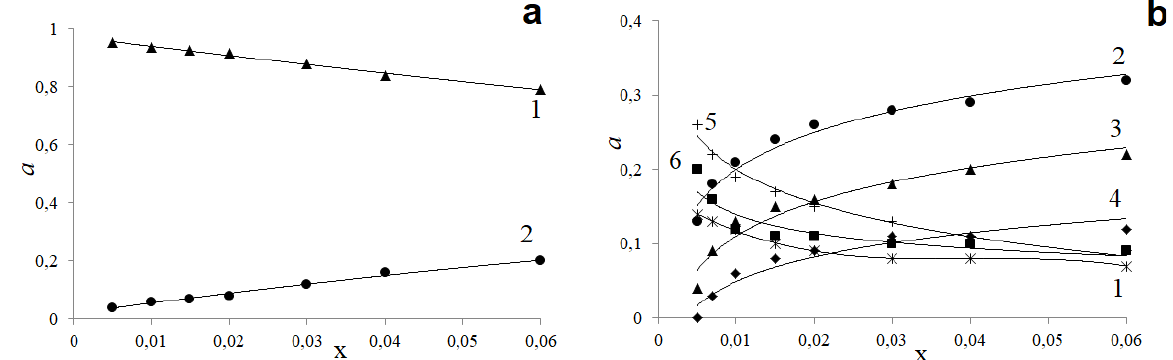
(1), dimers with the antiferromagnetic a dim ( a ) Figure 6: Dependence of portions of the monomers a mon Fe ( III ) types of exchange (5); trimers with antiferromagnetic a trim ( a ) (3); tetramers with the antiferromagnetic exchange type a tetr ( a ) Fe ( III ) ferromagnetic a tetr ( f ) types of exchange (6) on the content of iron atoms in Bi 2 Mg 1− x Fe x Nb 2 O 9+ δ (a) and Bi 2 MgNb 2−2 x Fe 2 x O 9− δ (b) Fe ( III ) cm −1 , in trimers J trim = −14 cm −1 and tetrameters J tetr = −9 cm −1 ; ferromagnetic – J dim = 20 cm −1 , in trimers J trim = 16 cm −1 and tetrameters J tetr = 11 cm −1 . Comparison of